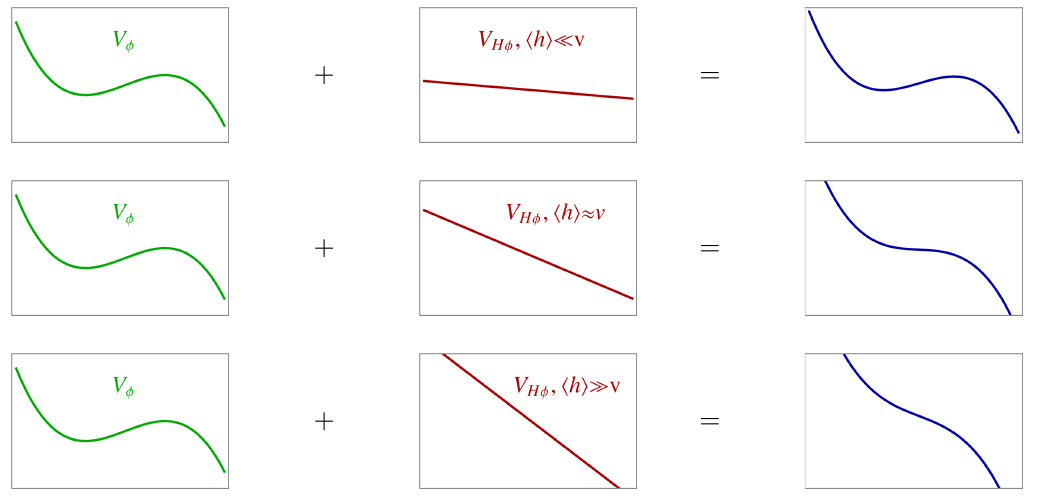
Figure 3 . Schematic structure of how the Higgs-dependent potential V Hφ can affect the scalar potential V φ to trigger a qualitative change when h h i ’ v